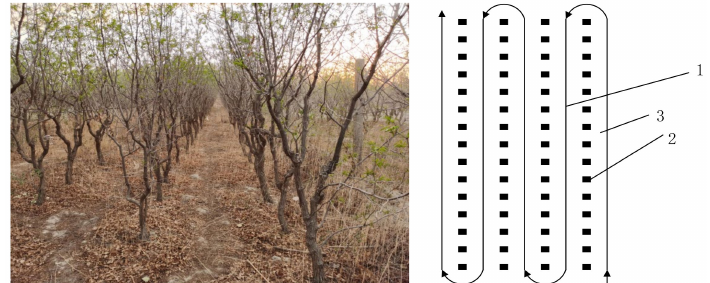
Figure 1. Navigation and positioning for plant protection operations in densely planted jujube orchards. 1. Robotic plant protection navigation paths; 2. Dwarf densely planted jujube; 3. aisle between